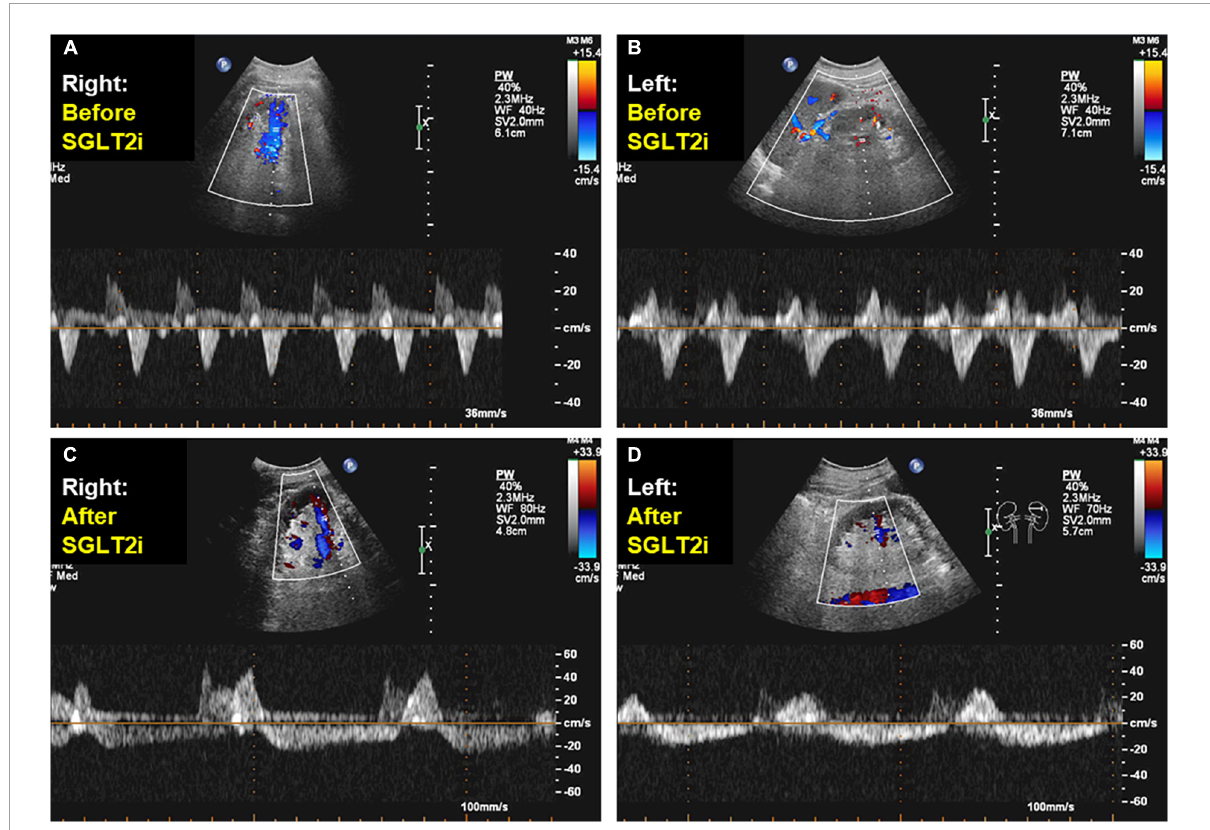
FIGURE3 Doppler-derived intrarenal venous flows before and after sodium-glucose cotransporter 2 inhibitor administration. After adding sodium-glucose cotransporter 2 inhibitor during 1 months, in color doppler flow images from the right and left kidney, intrarenal venous flow changed from a monophasic (A,B) to a discontinuous pattern with a systolic interruption (C,D)